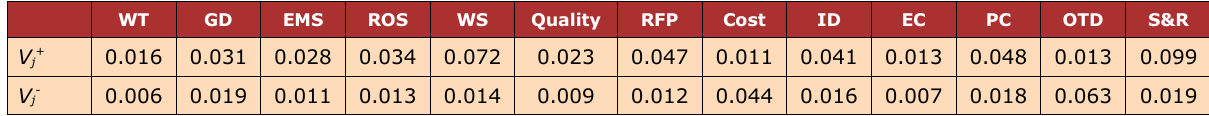
Table 13. Weighted normalized decision matrix